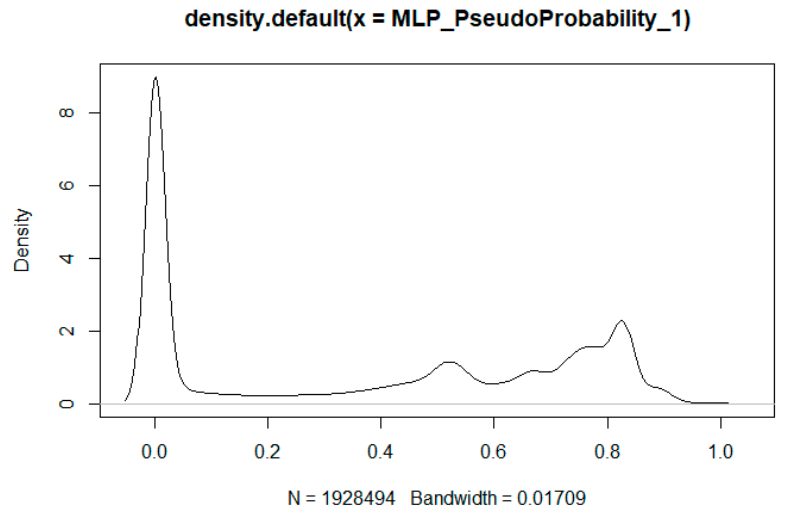
Figure 7. Density function for determining tax fraud probability. Source: Our own estimations .